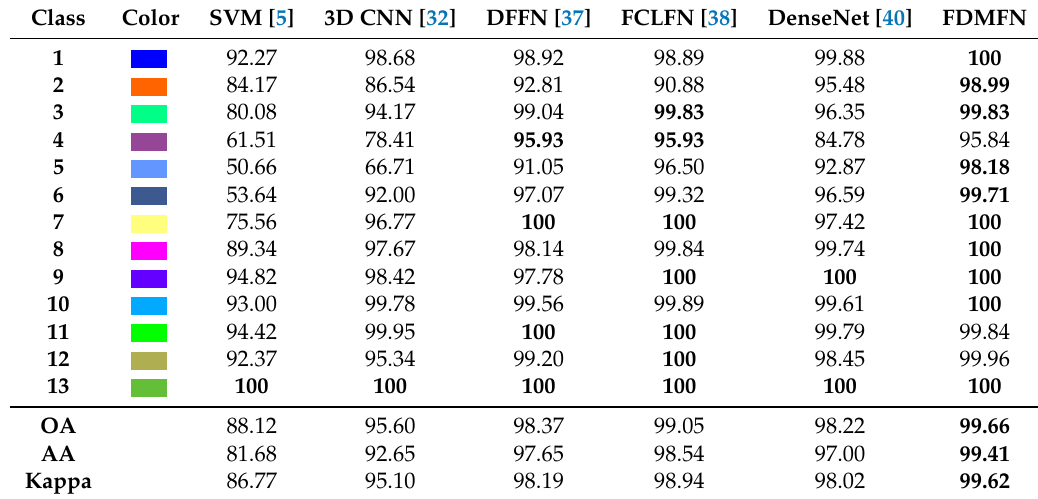
Table 8. Classification accuracies (in %) of different methods for the KSC dataset using 5% of labeled samples for training. The best results are highlighted in bold font.